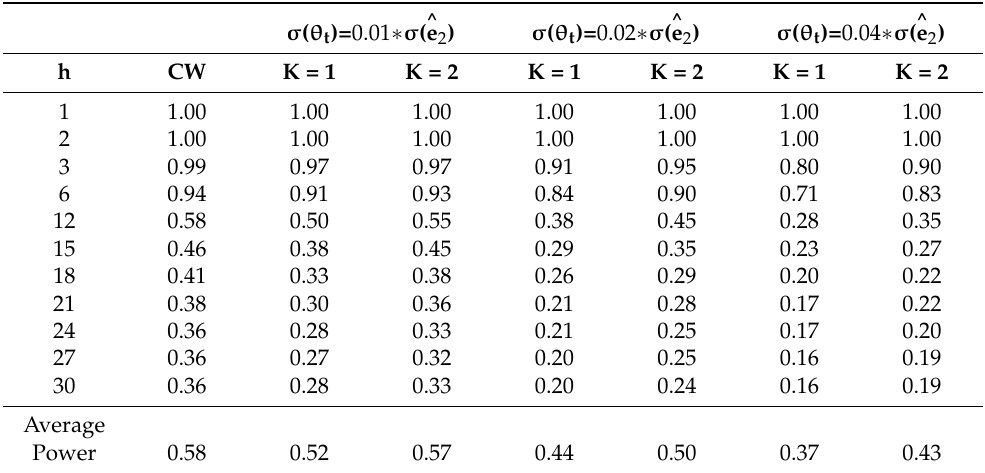
Table 10. Power comparisons between CW and WCW tests with nominal size of 10%, considering DGP2 and a small